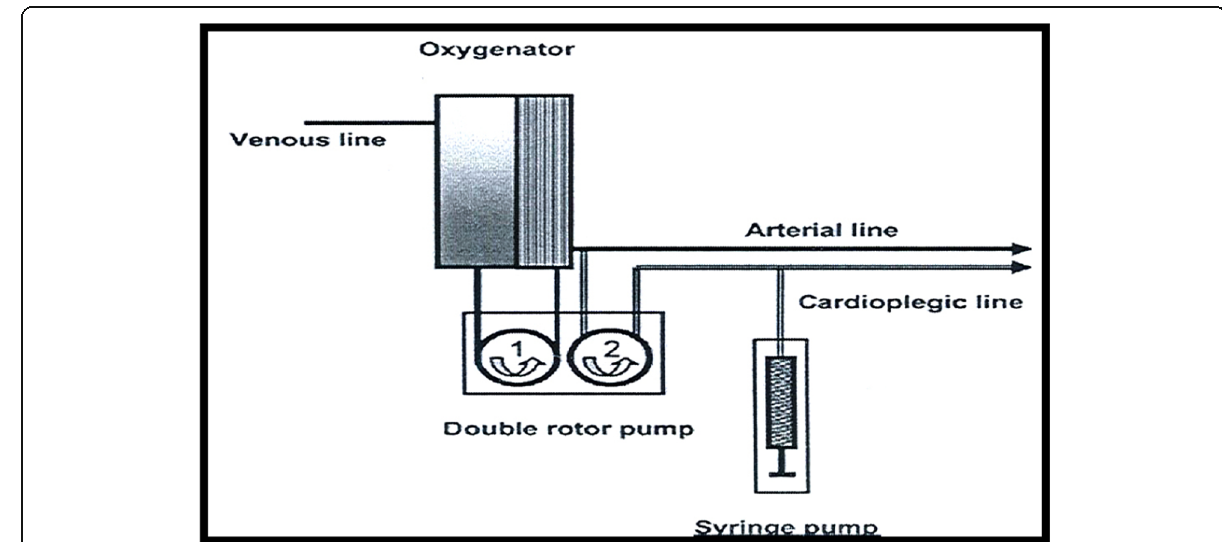
Fig. 1 Method of delivery of warm blood